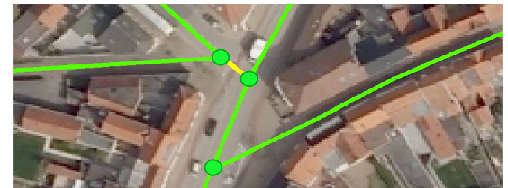
Figure 7: Topologic Analysis: short road objects are not verified by one of the verification modules. They are = green, undecided =